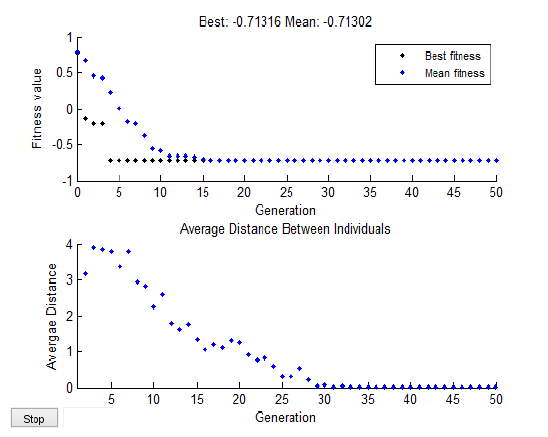
Fig. 13. Best fitness value for :; circular trajectory and average distance between individuals.